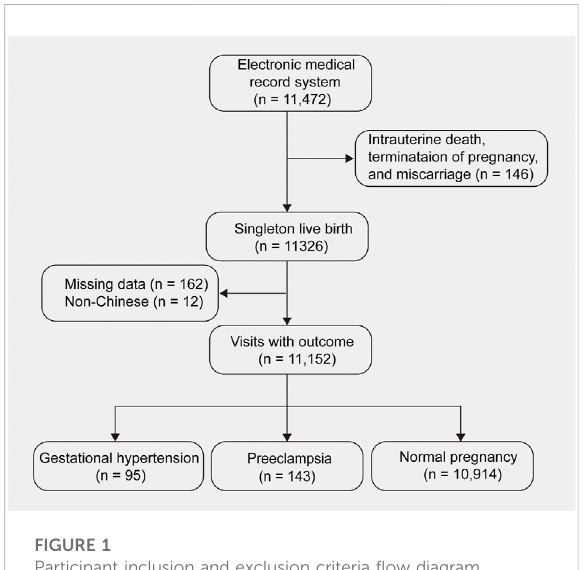
FIGURE 1 Participant inclusion and exclusion criteria fl ow